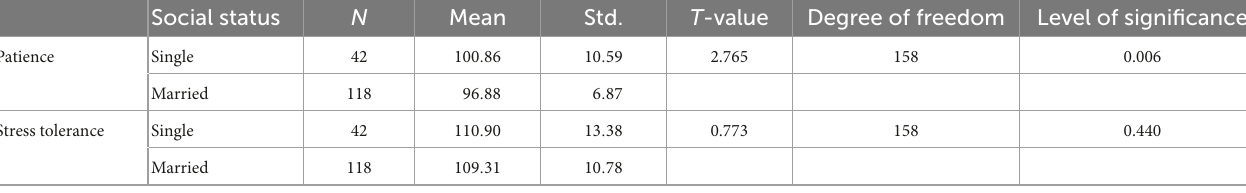
TABLE 4 Results of t -test for variance in total means of level of patience and stress tolerance, due to exposure to COVID-19 infection. Have you been infected N Mean Std. T -value Degree of freedom Level of significance with corona? Patience Yes 44